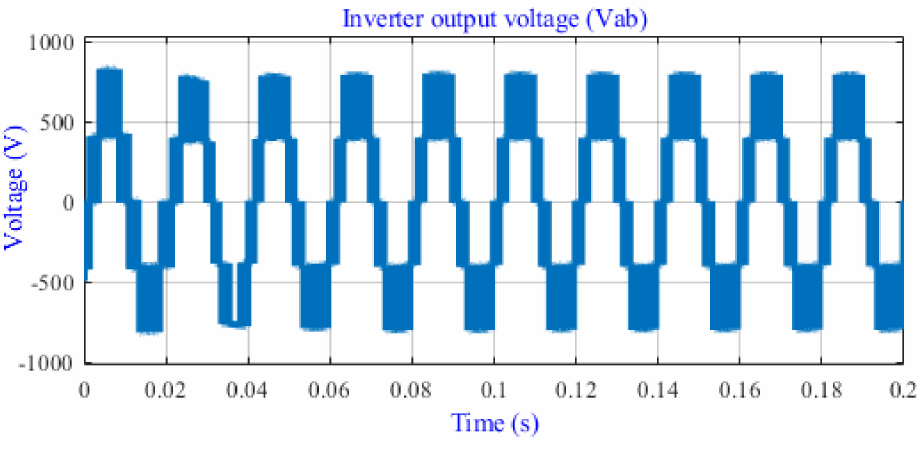
Figure 14. Inverter voltage (V ab